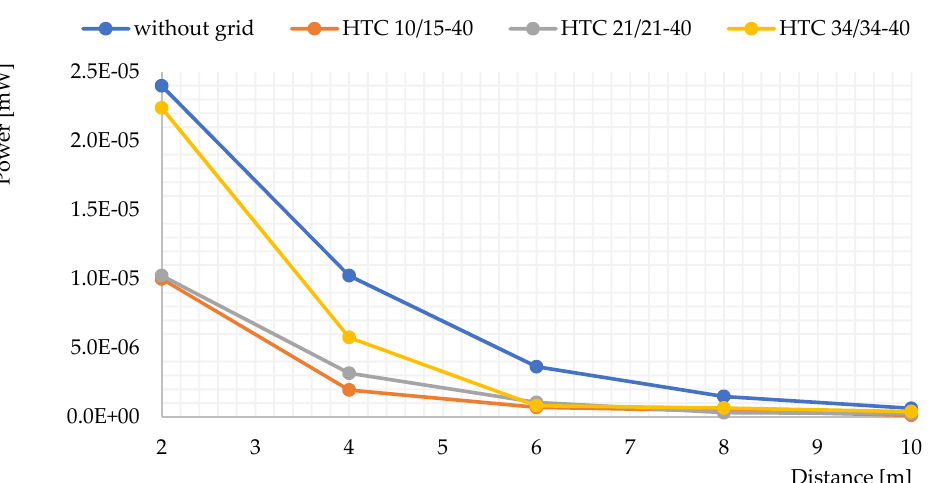
Figure 9. Signal shielding performance of the carbon grids along the test area. According to the results, HFC 21/21 is the most suitable for the current purpose.